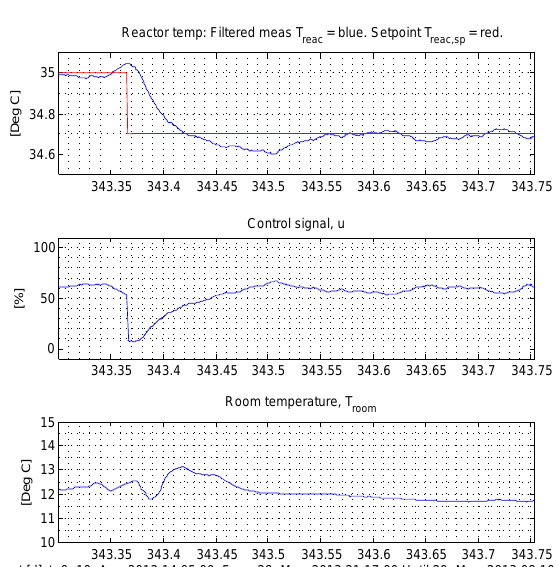
Figure 8: Real time-series for reactor with PI tem- perature controller tuned with the Skogestad